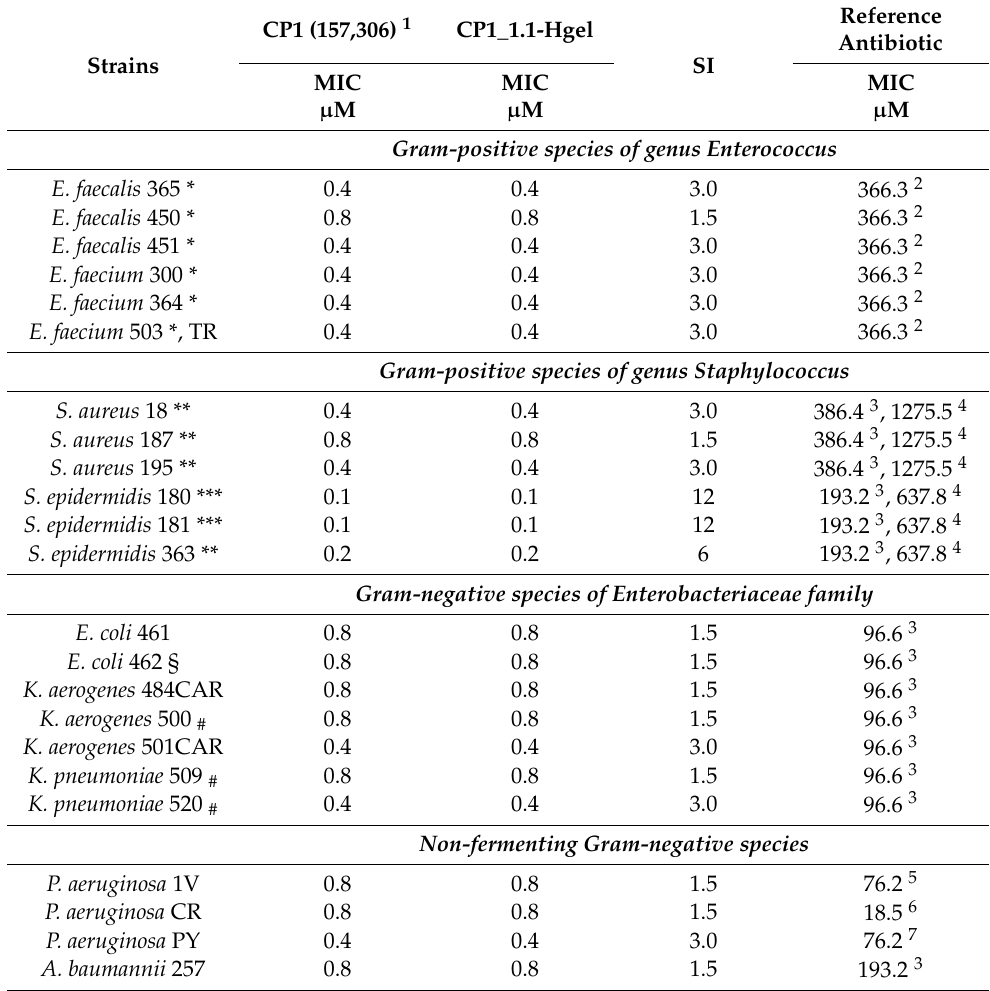
Table 6. MIC values of copolymer CP1 and of CP1_1.1-Hgel carried out in triplicate, expressed as µ M, computed SI values and MICs of some reference